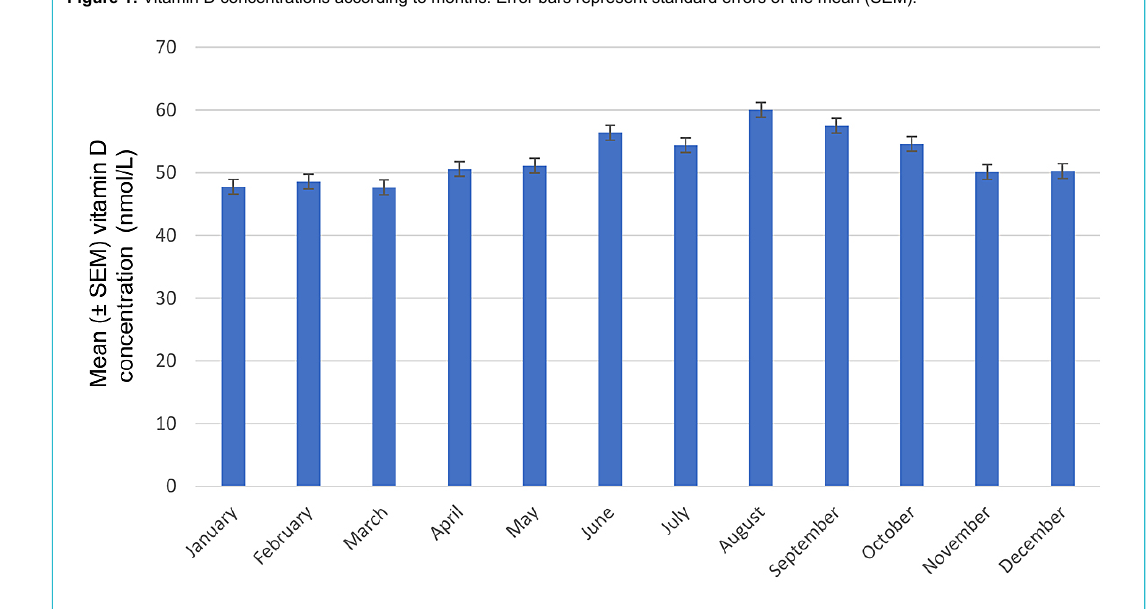
Figure 1: Vitamin D concentrations according to months. Error bars represent standard errors of the mean